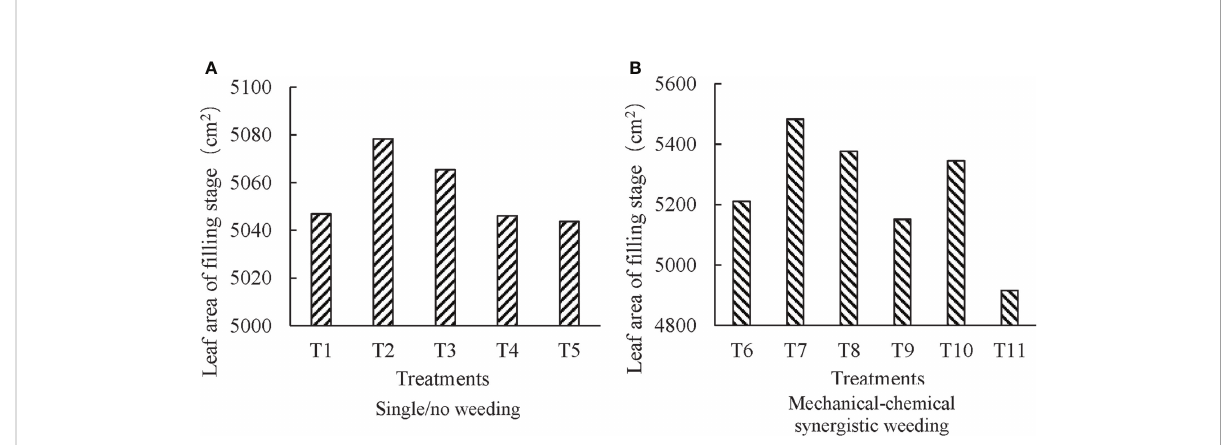
FIGURE 2 Effects of different weeding treatments on leaf area of fi lling stage (A) , single/no weeding treatments and (B) , mechanical-chemical synergistic weeding